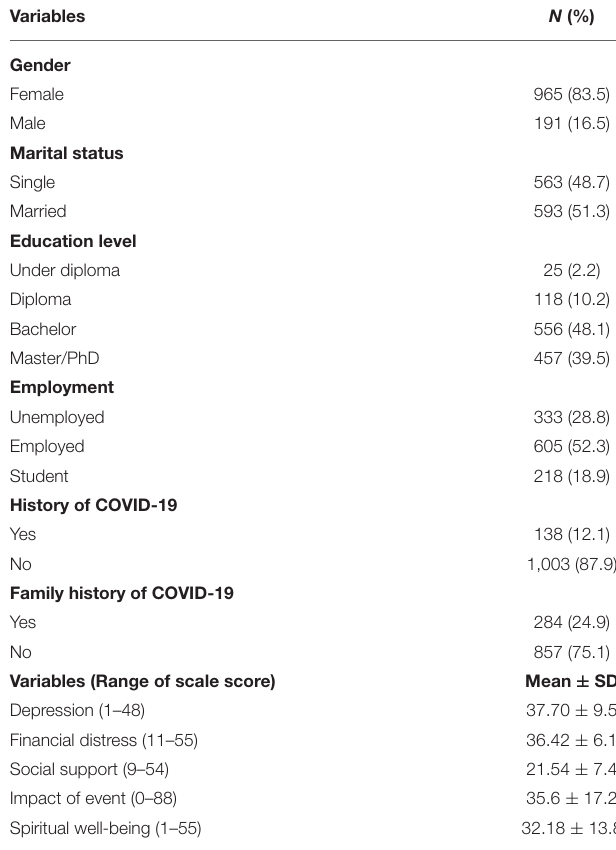
TABLE 1 | Demographic characteristics of participants ( n = 1,156).